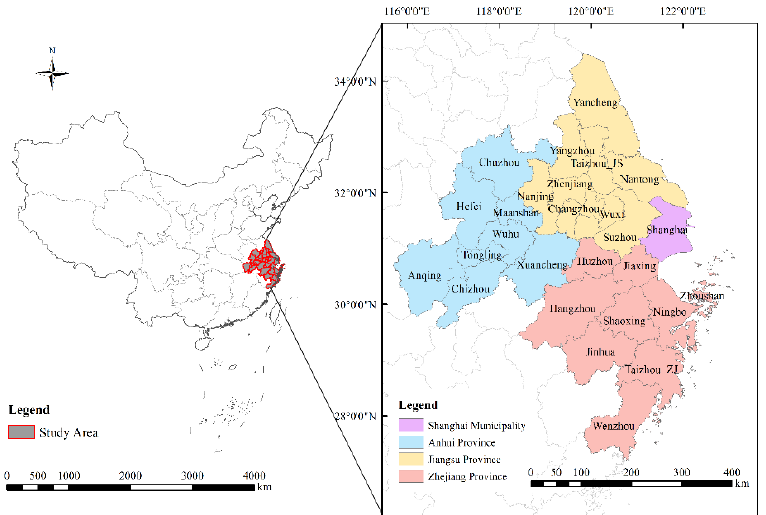
Figure 1. Locational map of the study area Yangtze River Delta Urban Agglomeration, China.